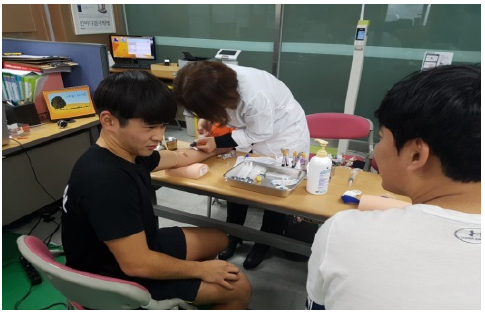
Table 4. Changes in fatigue recovery parameters.